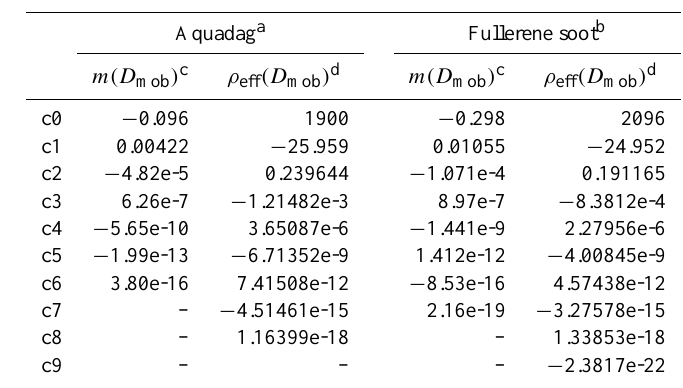
Table 1. Polynomial coefficients for the mass, m [fg], and effective density, ρ eff [kgm − 3 ], of Aquadag and fullerene soot as a function of mobility diameter, D mob [nm]. Warning: Do not round below coefficients to less significant digits.